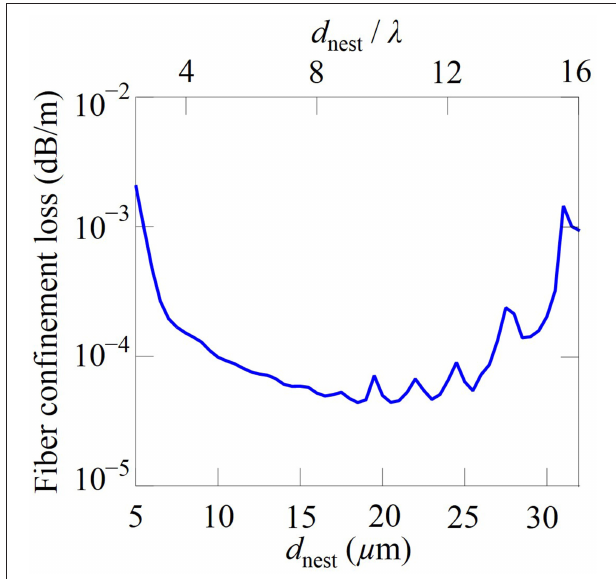
FIGURE 7 | Fiber confinement loss as a function of diameter of the nested tube. No material loss is included. We set λ = 2 µ